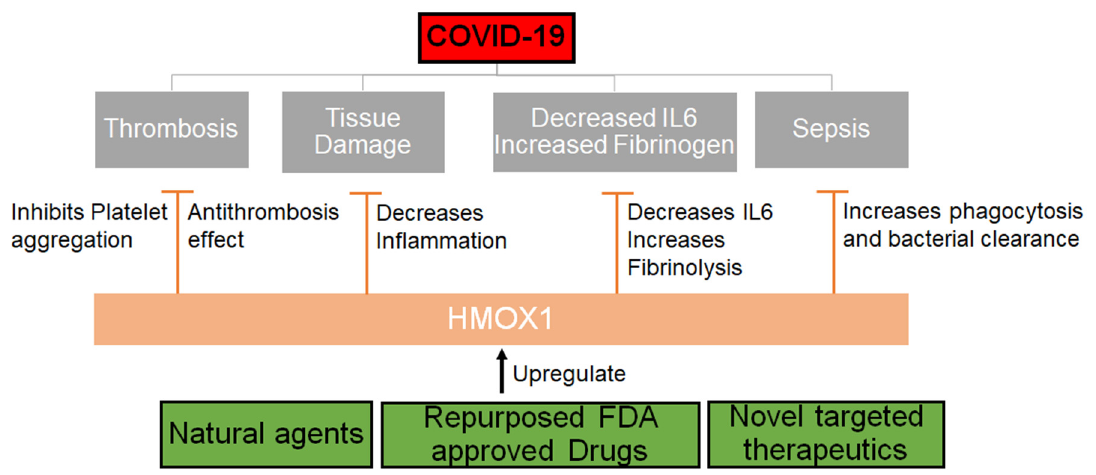
Figure 2. Mechanism through which HMOX1 can be regulated. HMOX1 that can be upregulated by either natural compounds or synthetic molecules may inhibit the effects of SARS-CoV-2 by decreasing inflammation, IL6 levels and increasing phagocytosis, fibrinolysis and thereby inhibiting thrombosis and sepsis.